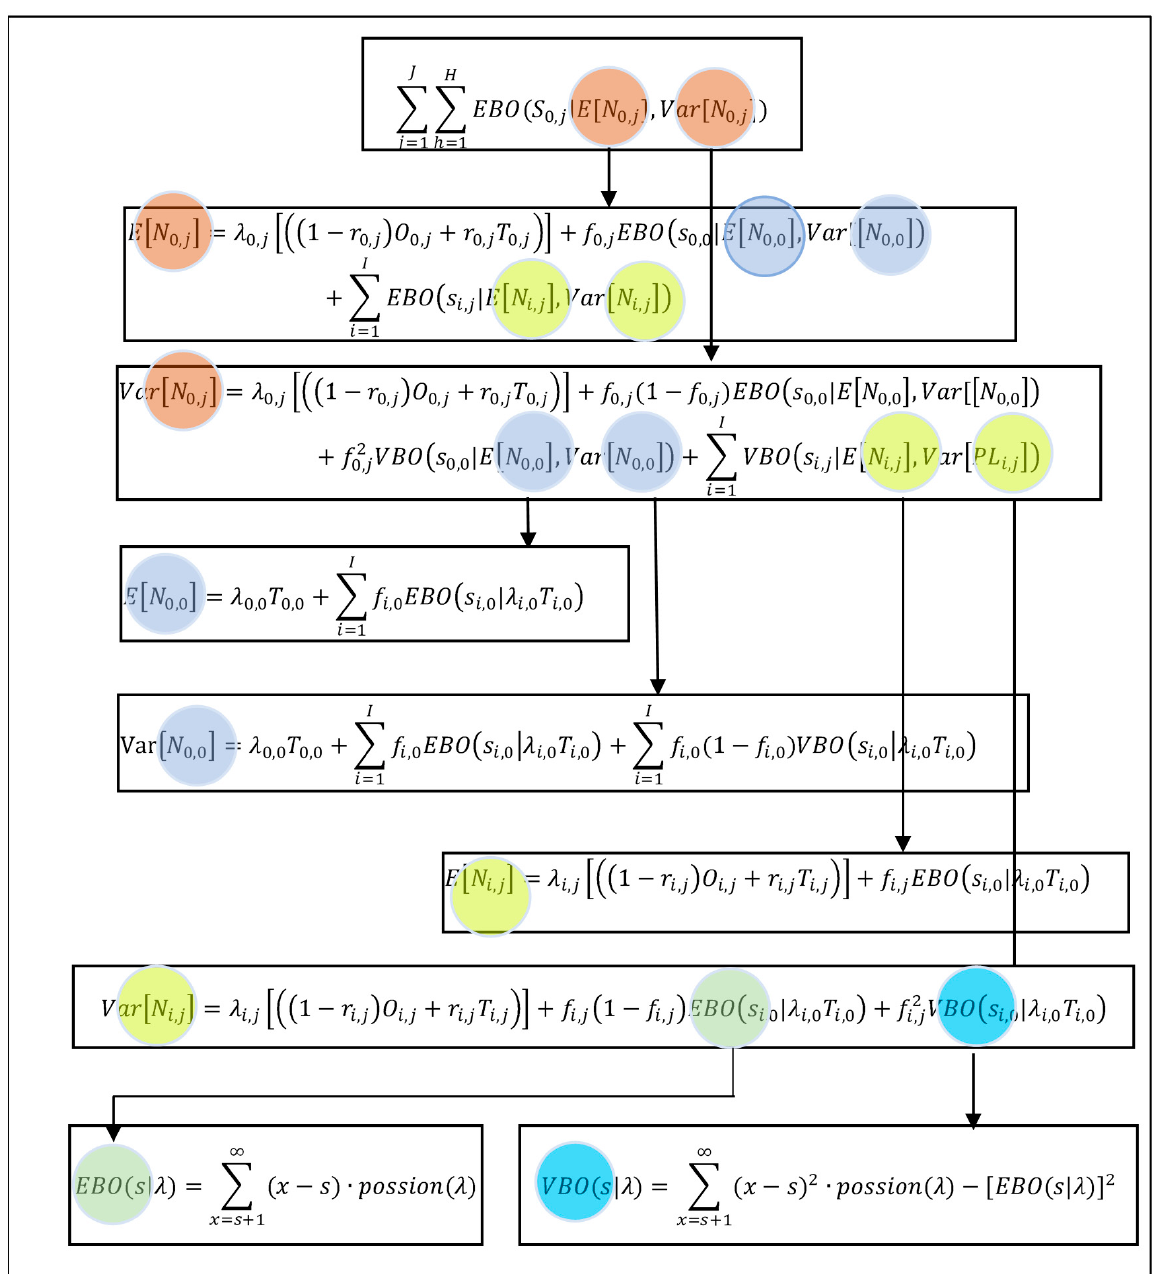
Figure 3. System EBO solution process.